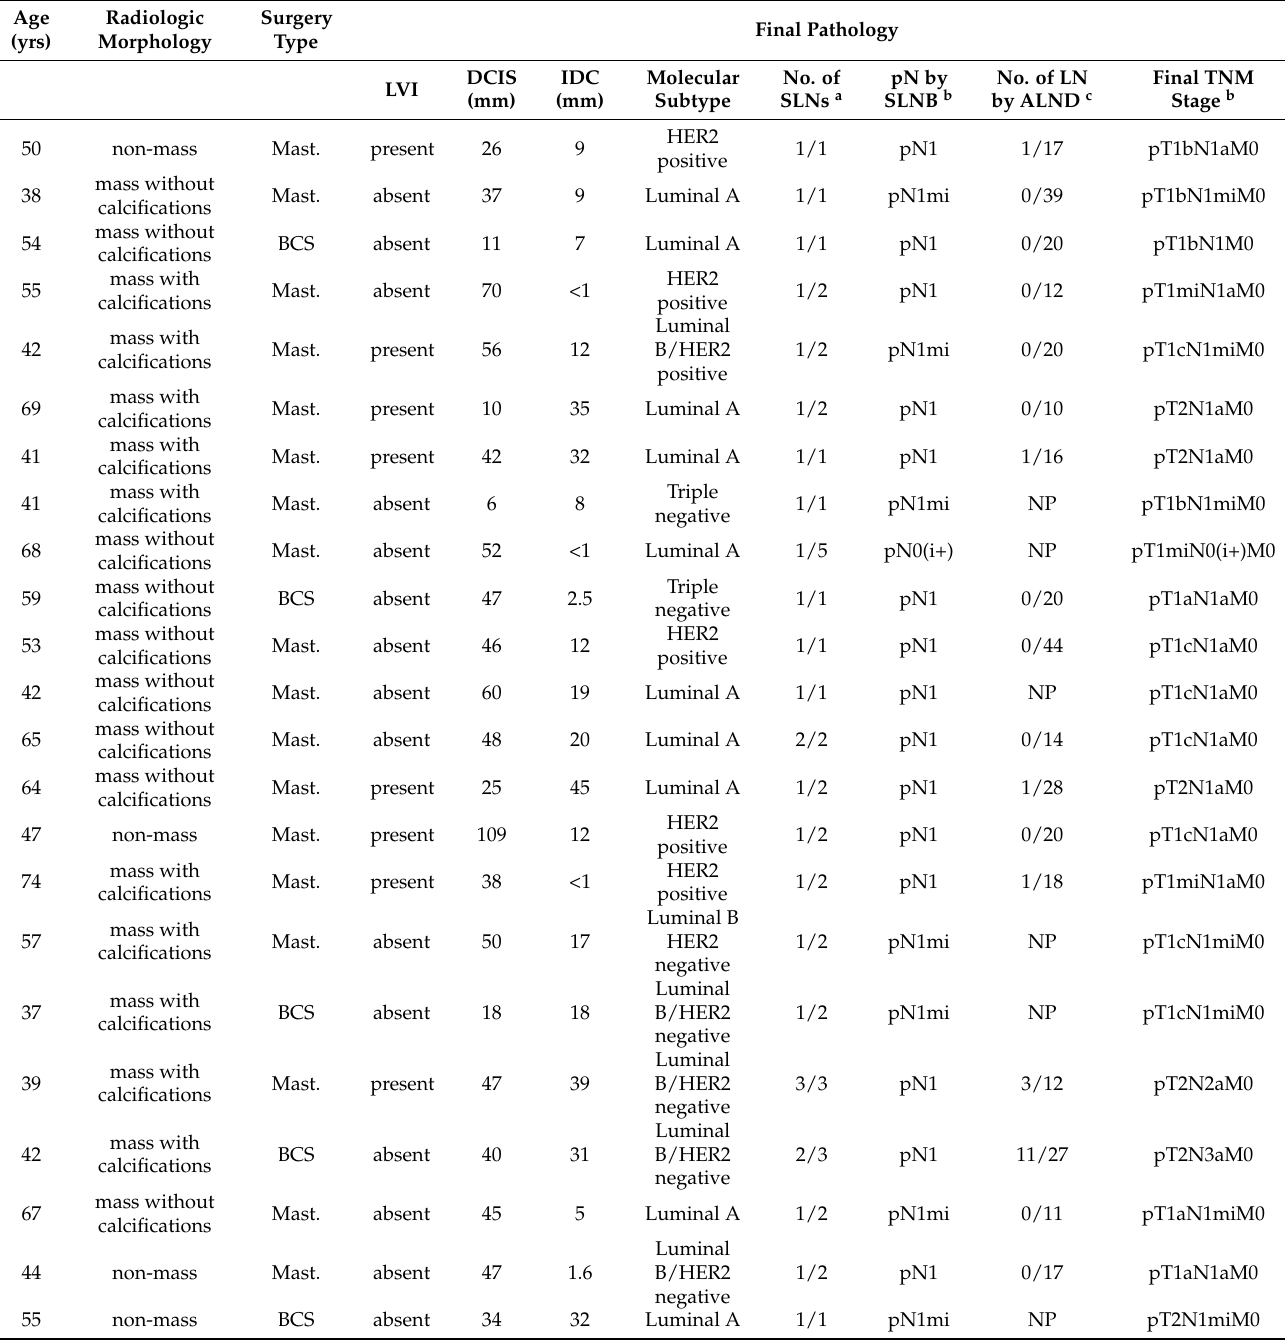
Breast conserving surgery; NP, not performed. a Values in table are numbers of sentinel lymph nodes removed (positive/examined). b Tumor size and lymph node status were categorized according to the eight edition of the American Joint Commission on Cancer TNM staging system for breast cancer. c Values in table are numbers of additional lymph nodes removed by subsequent axillary lymph node dissection